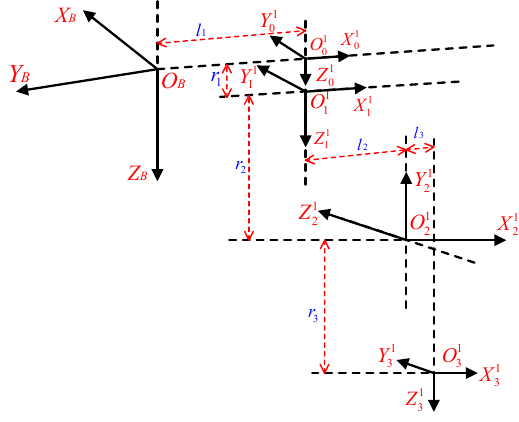
Figure 5. Kinematics model of the left foreleg of ASR-III. Table 1. The Denavit-Hartenberg (D-H) parameters of the left foreleg.